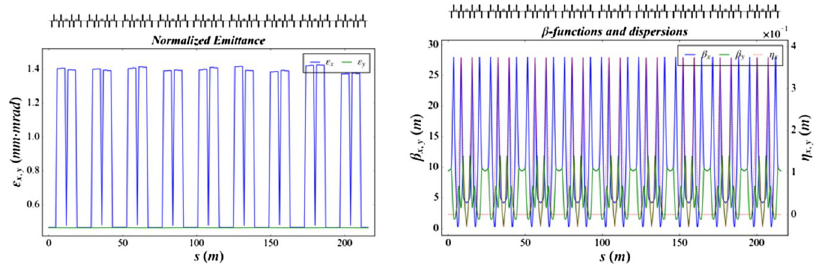
Figure 10. The emittance evolution (left) and the optical function (right) along the 1.5 GeV